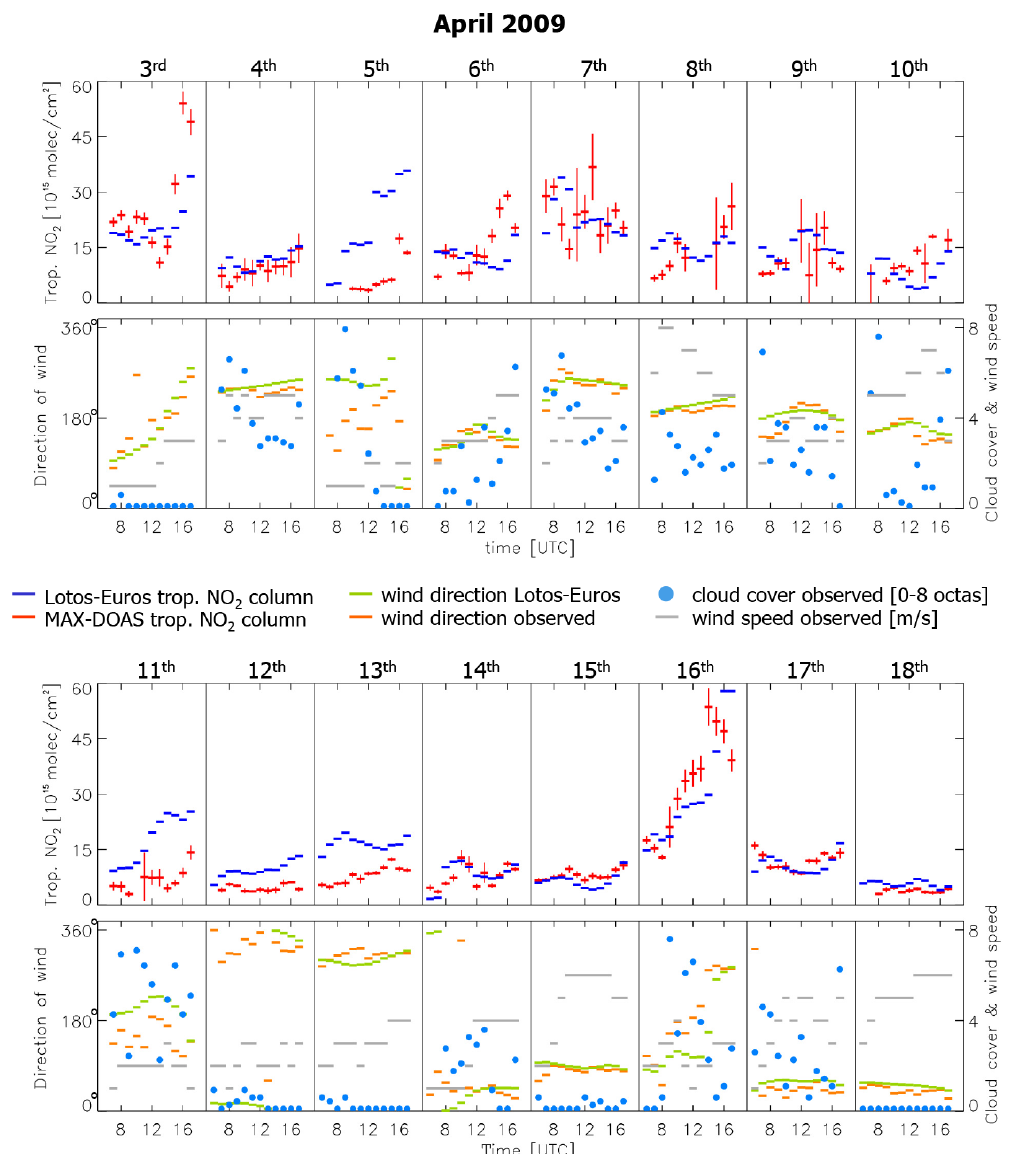
Figure 5. Comparison between MAX-DOAS and Lotos-Euros tropospheric NO 2 columns and simultaneous meteorological conditions for 16 days in April 2009. The uncertainty in the MAX-DOAS retrieval is determined from the rms of the individual observations that are averaged over